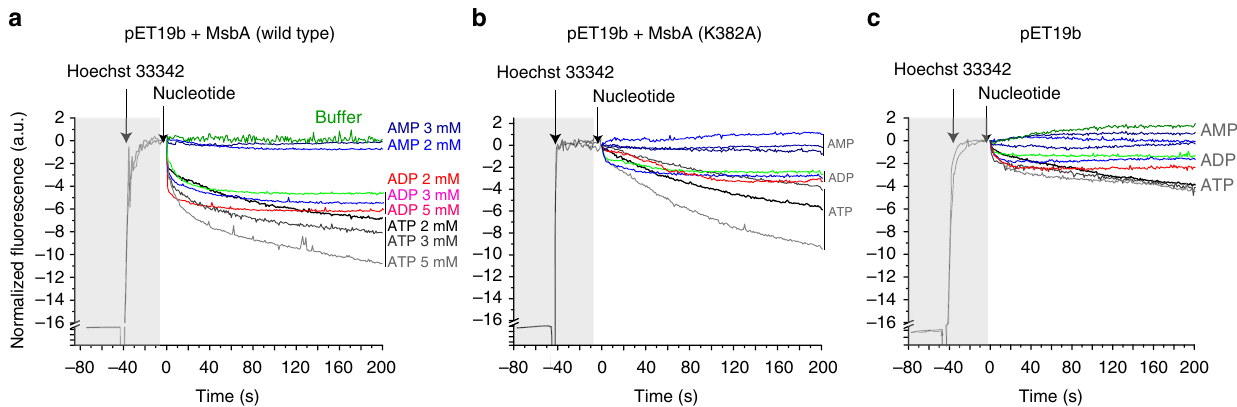
Figure 6 | Transport of Hoechst-33342 by MsbA into E. coli ISOVs probed by fluorescence spectroscopy. ( a ) ISOVs containing MsbA show a concentration-dependent substrate transport for ATP. Upon addition of AMP, no transport is detected. However, increasing amounts of ADP also lead to transport. ( b ) ISOVs containing the MsbA K382A mutant show much slower but still ATP concentration-dependent transport. The effects in the presence of ADP are much less pronounced and within the range observed for ISOVs prepared from E. coli induced with an empty vector ( c ). The latter shows almost no ATP concentration-dependent transport. The small, observed effects could be because of the native E. coli ABC transporters and other proteins in the membrane of E. coli . All experiments were repeated in